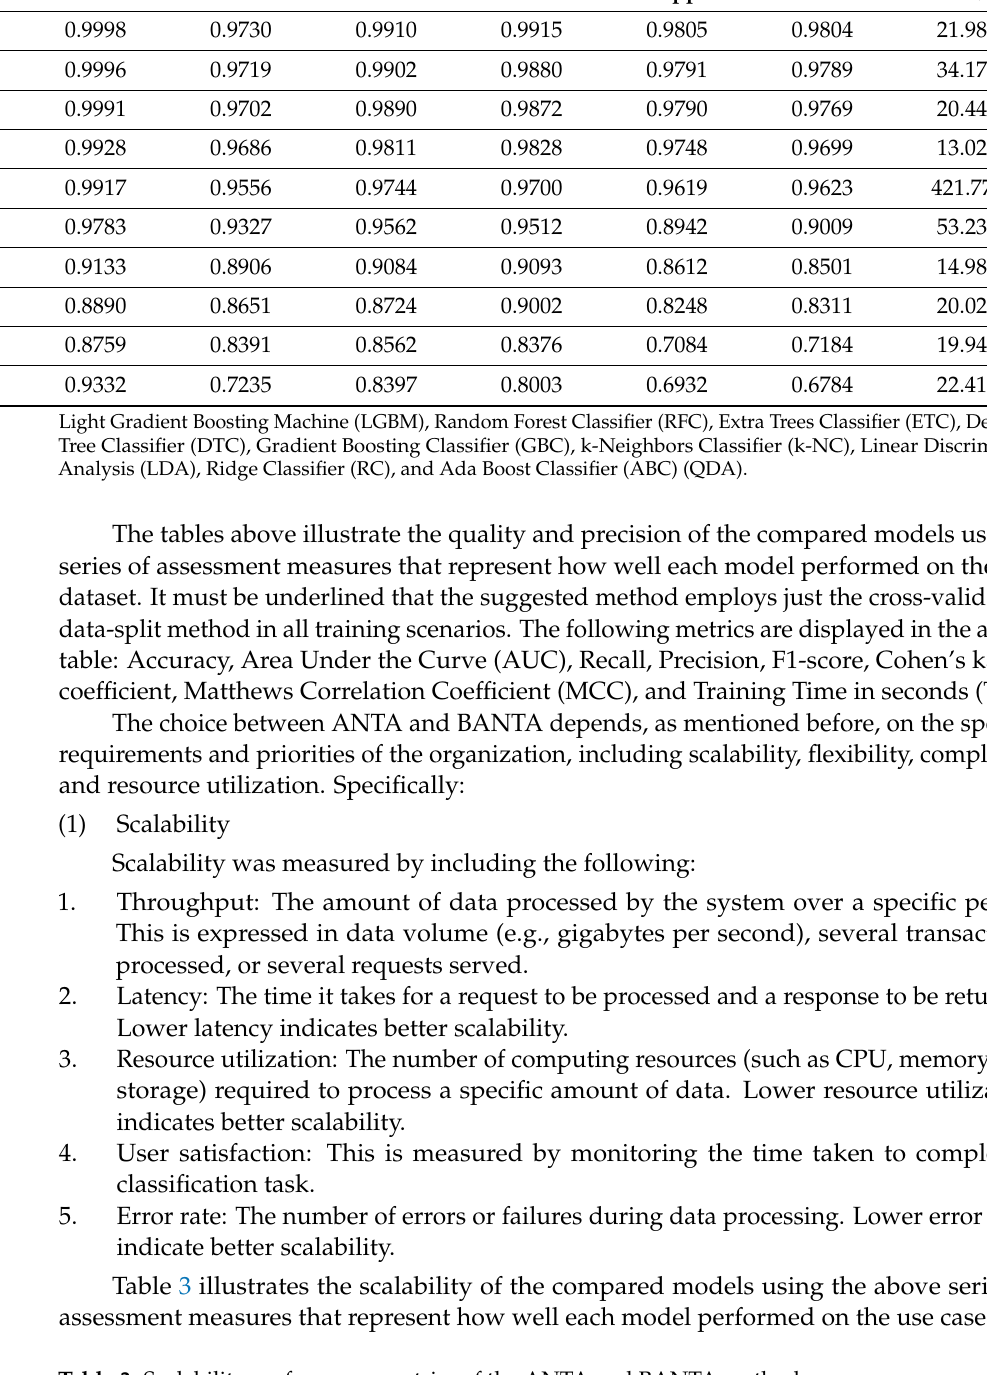
Table 2. Performance metrics of the BANTA method (model selection process).